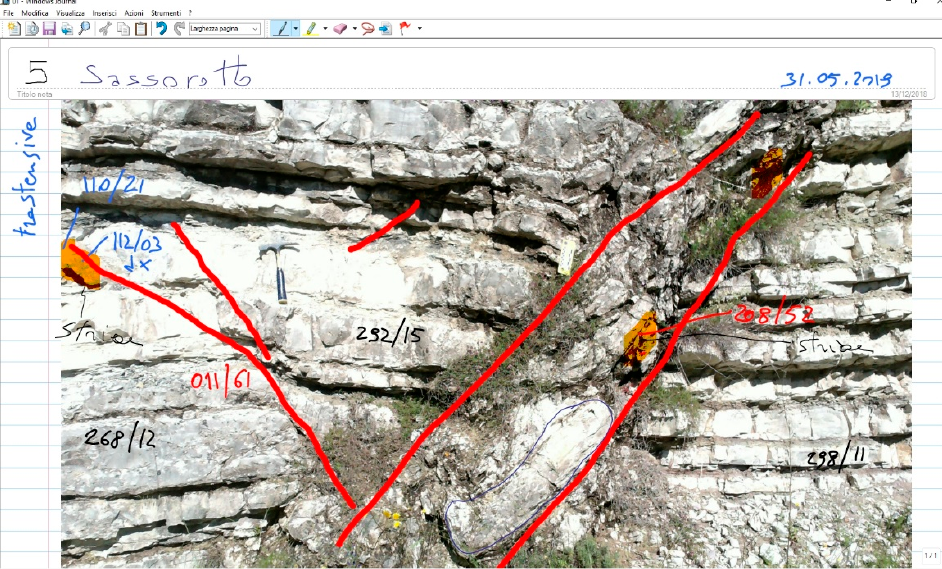
Figure 9. Windows Journal note of the Sassorotto site (A1 site; see Figure 2 for location). The thick red lines are fault surfaces; black data (dip direction / dip) are bedding attitudes; red are fault surface data; blue are fault lineation data. Hammer for scale.